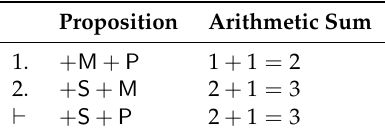
Table 4. An interpretation of iii -1.